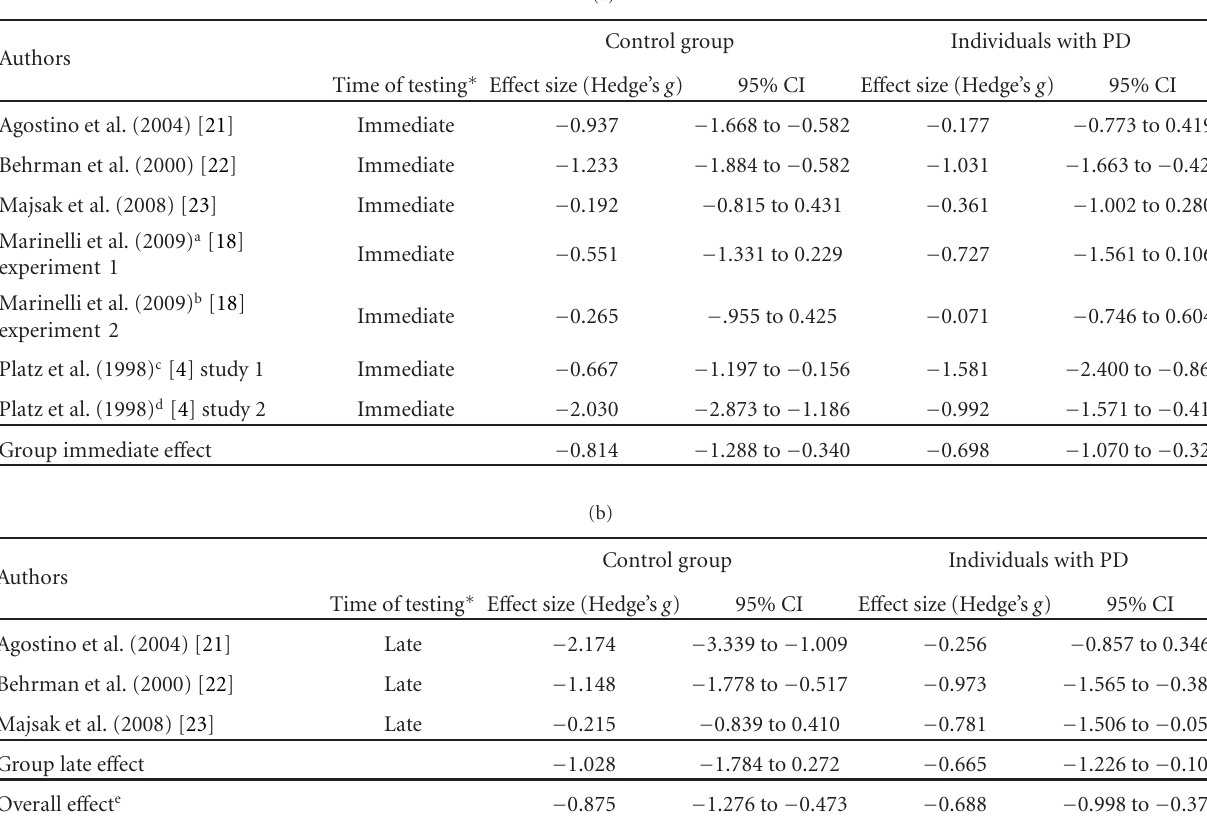
Table 5: E ff ect sizes (as measured using Hedge’s g ) with upper and lower 95% confidence intervals for the studies included in the meta- analysis and the resultant e ff ect sizes. A negative value of the e ff ect sizes is indicative of a reduction in the movement time.